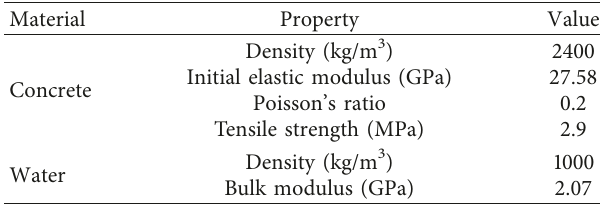
Figure 2: Stress-strain constitutive relation of dam concrete in uniaxial tension [21]. Table 1: Material properties of dam concrete and reservoir